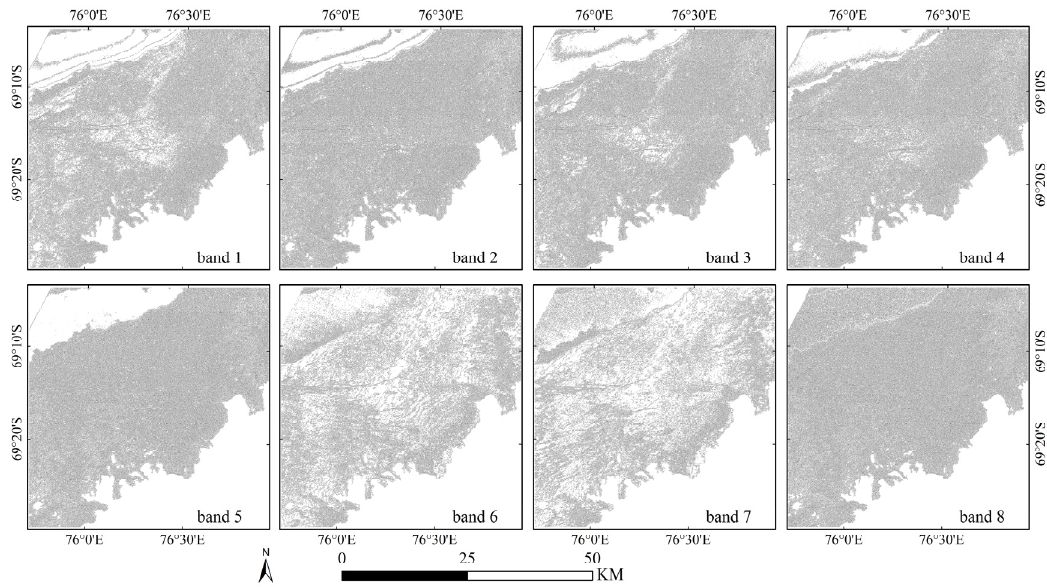
Figure 5. The line segments extracted by the LINE module from Bands 1–8 using the vertical direction gradient data with a resolution of 15 m as input images.